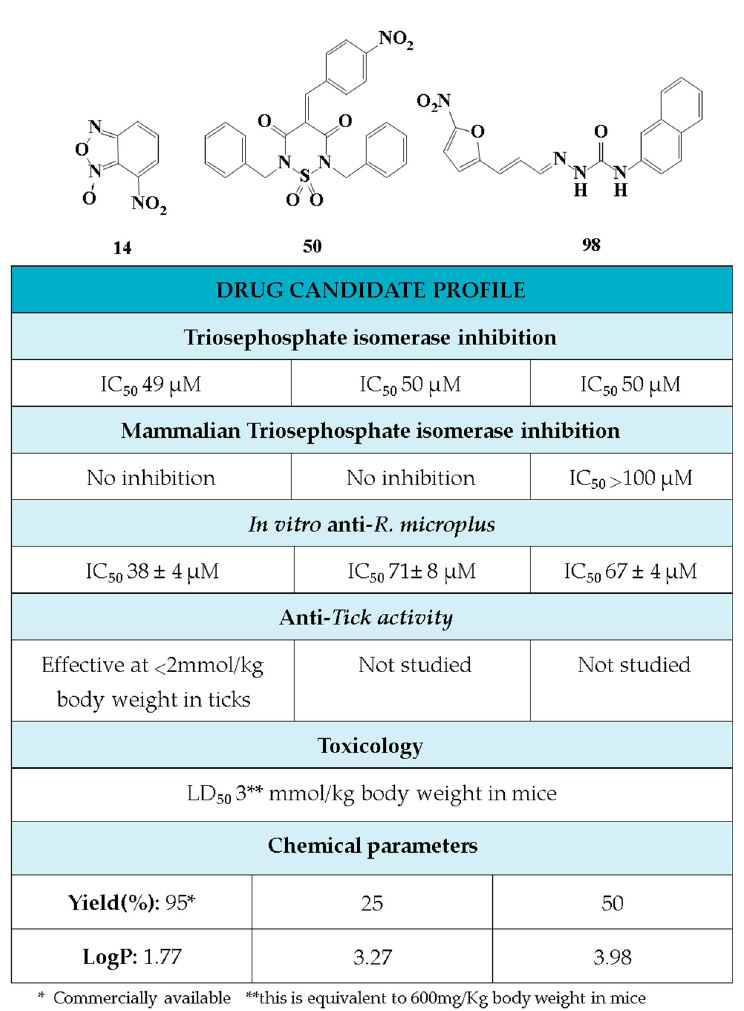
Figure 6. Drug Candidate Profile. An abstract of the pharmacological information compiled in this work for the identified hit compounds 14 , 50 , and 98 .